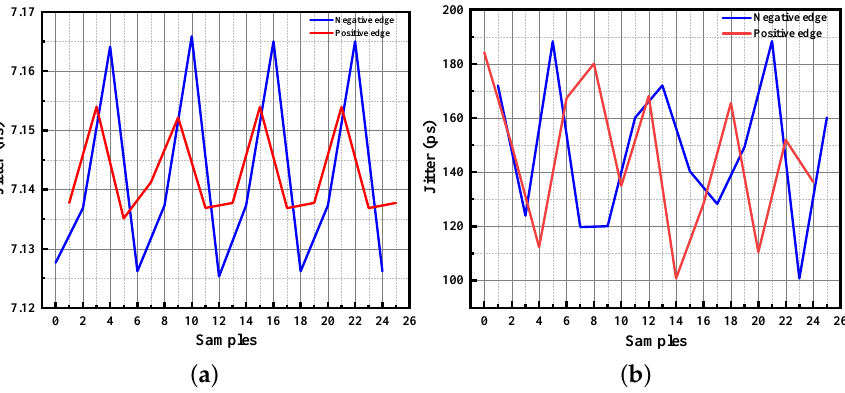
Figure 16. Simulated input/output jitter. ( a ) Input clock jitter; ( b ) Output clock